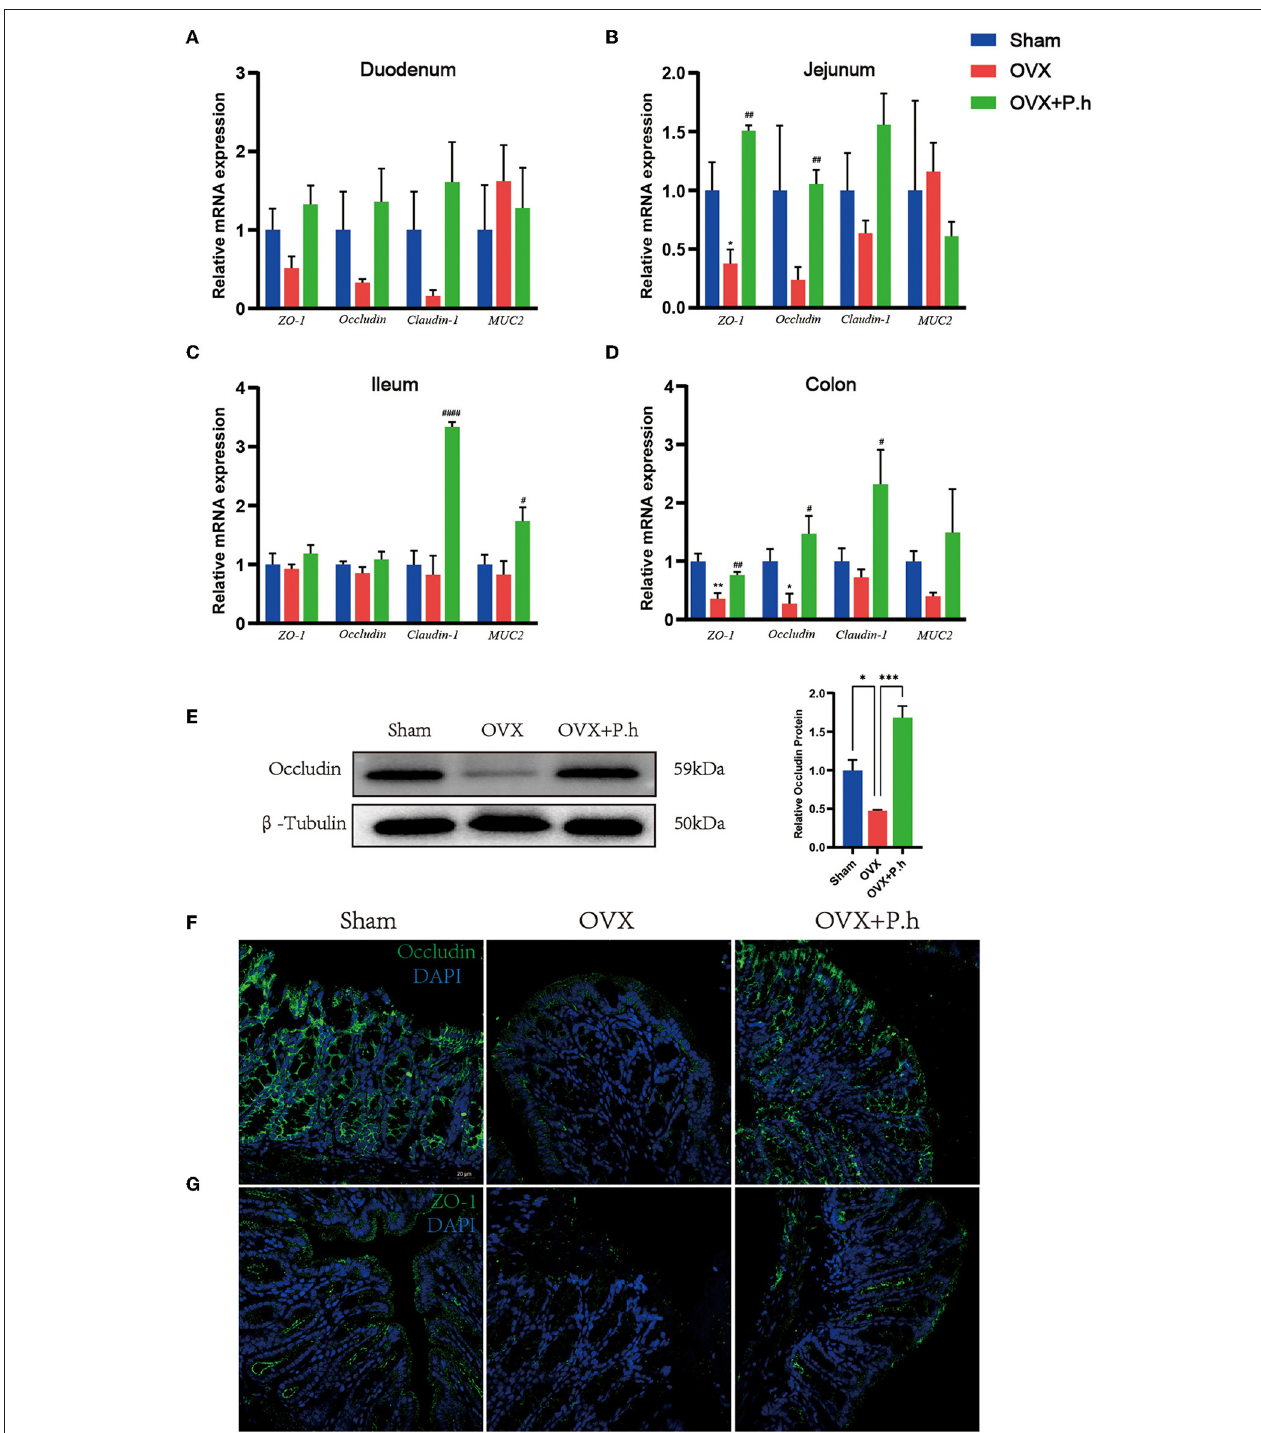
FIGURE 5 | P. histicola restored intestinal leakage in OVX mice. (A) The mRNA expression of ZO-1, occludin, claudin-1, MUC2 in duodenum. (B) The mRNA expression of ZO-1, occludin, claudin-1, MUC2 in the mRNA expression of ZO-1, occludin, claudin-1, MUC2 in jejunum. (C) The mRNA expression of ZO-1, occludin, claudin-1, MUC2 in ileum. (D) The mRNA expression of ZO-1, occludin, claudin-1, MUC2 in colon. (E) Western blotting analysis of occludin in colon. (F) Immunofluorescence of occludin in colon. Magnification 400 × . Scale bar = 20 µ m. (G) Immunofluorescence of ZO-1 in colon. Magnification 400 × . Scale bar = 20 µ m. Data are presented as means ± SEM ( n = 3–4/group). * p < 0.05 vs. sham, ** p < 0.01 vs. sham, *** p < 0.001 vs. sham, # p < 0.01 vs. OVX, ## p < 0.01 vs. OVX, #### p < 0.0001 vs. OVX.